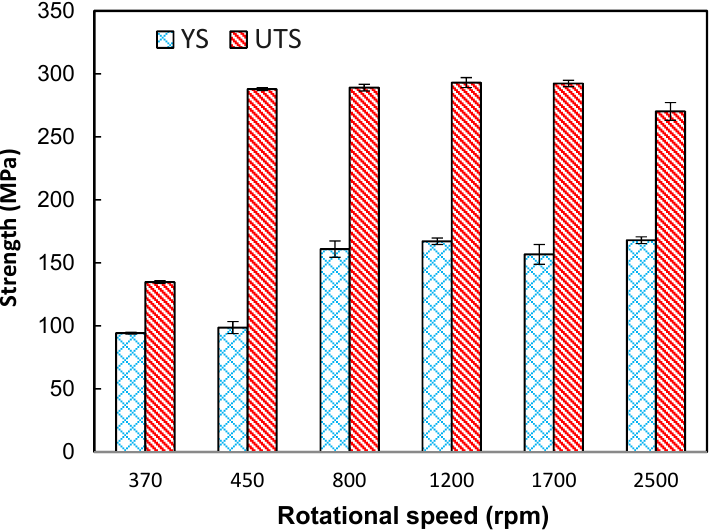
Figure 12. The tensile strengths of the weld joints at various rotational speeds.